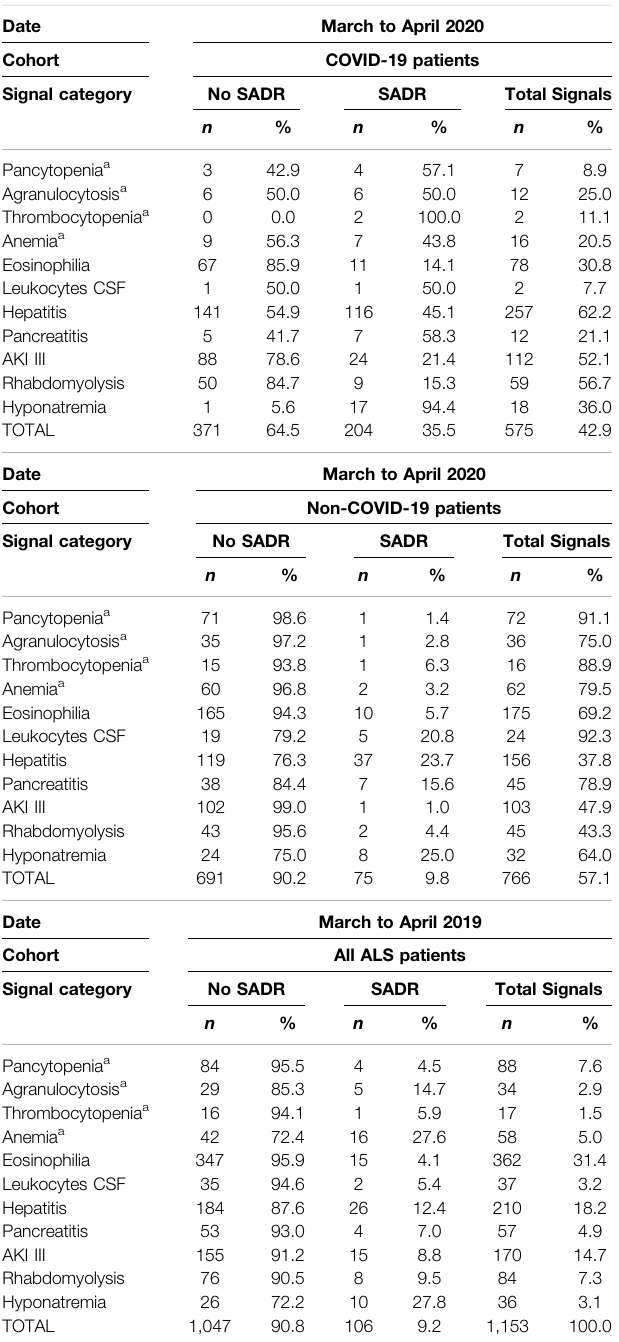
TABLE 2 | Breakdown by no SADR group vs. SADR group recorded from March to April 2020 in COVID-19 patients vs. non-COVID-19 patients.